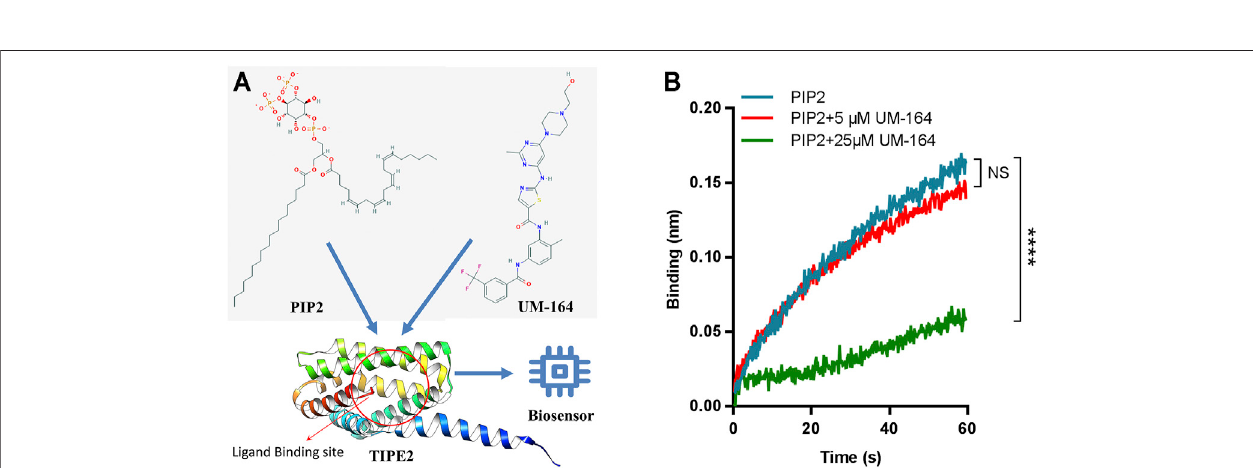
FIGURE 8 | Competitive binding to TIPE2 protein between PIP2 and UM-164. (A) Diagram of PIP2 and UM-164 competitive binding toTIPE2. (B) The competitive BLI results. For BLI assays, immobilized biotinylated TIPE2 proteins were bound to PIP2 in the presence of 5 μ M UM-164 (red) and 25 μ M UM-164 (green) and without UM-164 (blue), respectively, and then respective binding signals of PIP2 were shown. ****: compared with the group without UM-164, p < 0.0001 (unpaired t-test). NS, no signi fi